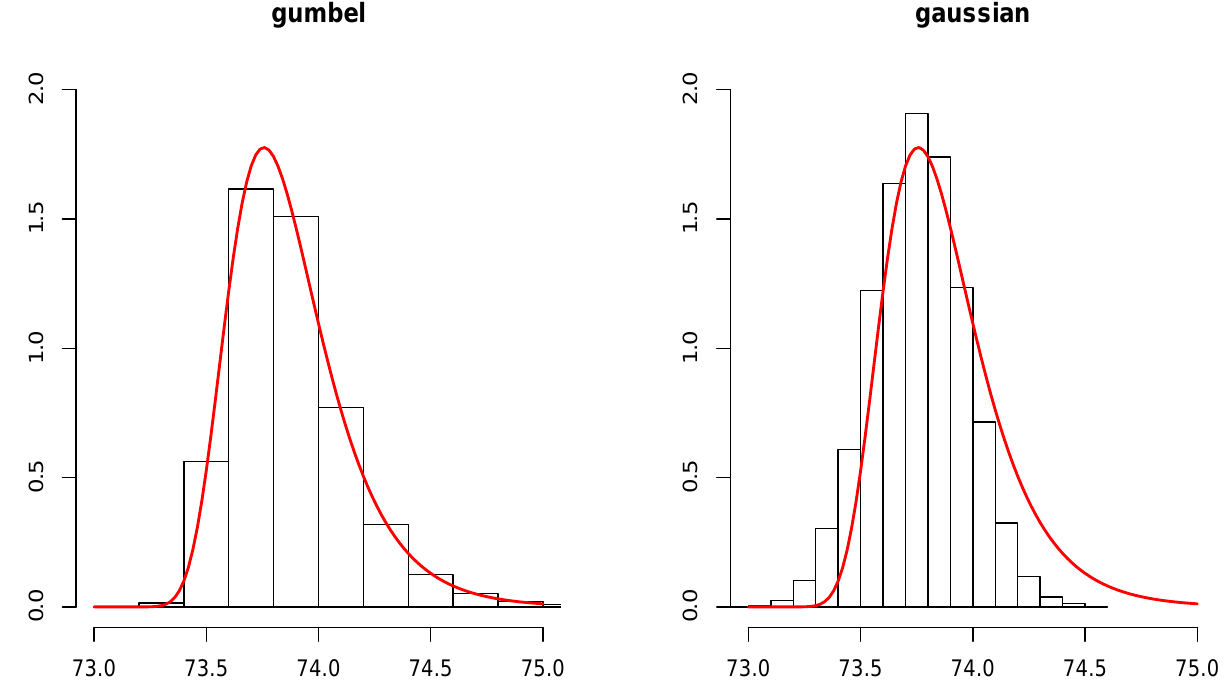
Figure 3. Conditional histograms of X t + 1 for the Gumbel model and Gaussian model for males with superimposed Gumbel density based the estimated